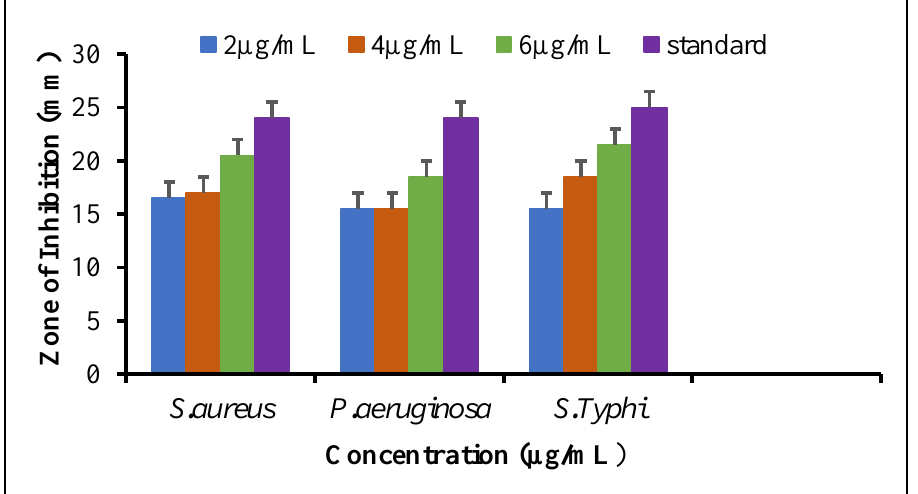
Figure 5. Antibacterial activity of synthesized Ag NPs.